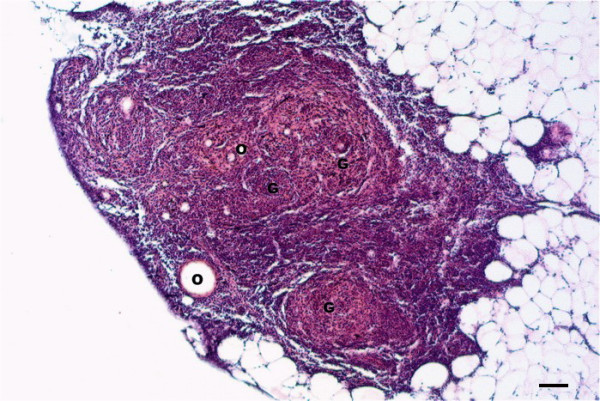
Granulomas at injection-site of Atlantic salmon at 12 weeks following injection. Well-circumscribed granulomas (G) induced by oil-adjuvanted vaccine containing standard amount of Moritella viscosa antigens. Note negative impression of oil droplets (O). Bar = 50 μm.